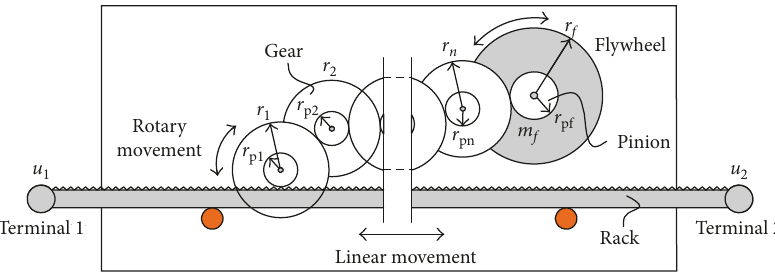
Figure 1: Schematic model of the inerter with rack and pinion mechanism.